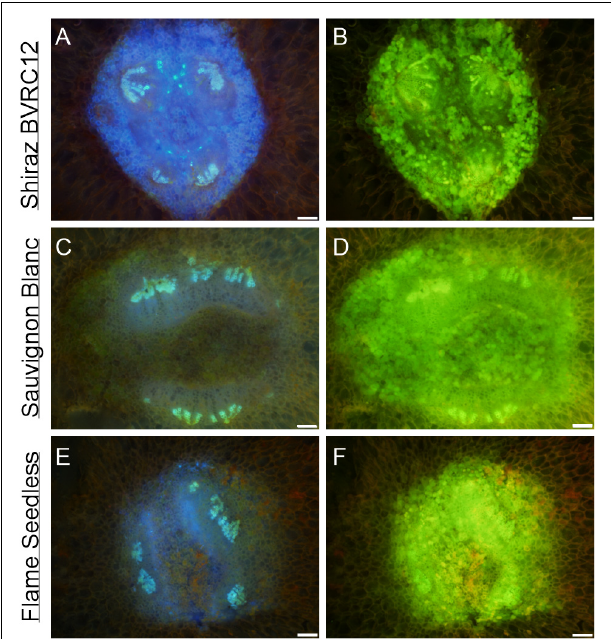
FIGURE 7 | Peripheral vascular bundles in the receptacle and the receptacle/berry junction. Receptacle vascular system branched toward the epidermis of the receptacle in the pre-veraison Shiraz BVRC12 (A) , post-veraison Sauvignon Blanc (B) , and pre-veraison Flame Seedless (C) . Vascular bundles in the receptacle/berry junction of post-veraison Shiraz 1654 (D) , pre-veraison Flame Seedless (E) , and post-veraison Ruby Seedless (F) (x, xylem; p, phloem; pvb, peripheral vascular bundle; cvb, central vascular bundle). Excitation filter 330–385 nm, dichroic mirror 400 nm and barrier filter 420 nm applied to methanol-fixed sections stained with acridine orange (A–C,E,F) and fresh section stained with aniline blue fluorochrome (D) . Scale bar = 100 µ m.